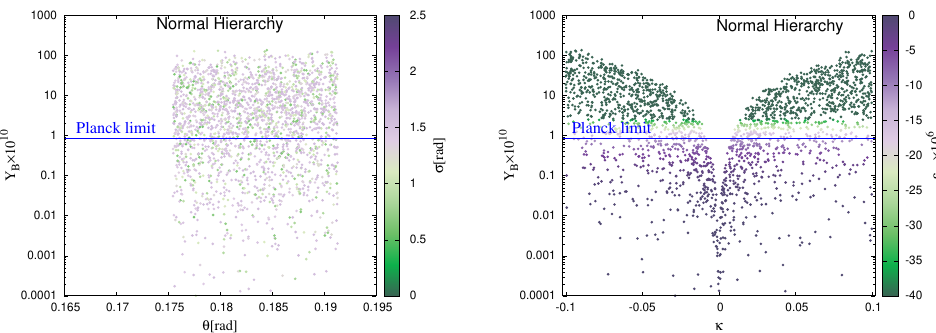
Figure 5 . Left panel: Y B as a function of the trimaximal parameters θ and σ . Right panel: Y B as a function of the parameter κ with the color code indicating the allowed range of the CP asymmetry parameter ε . The horizontal blue line corresponds to the Planck bound on Y N 3